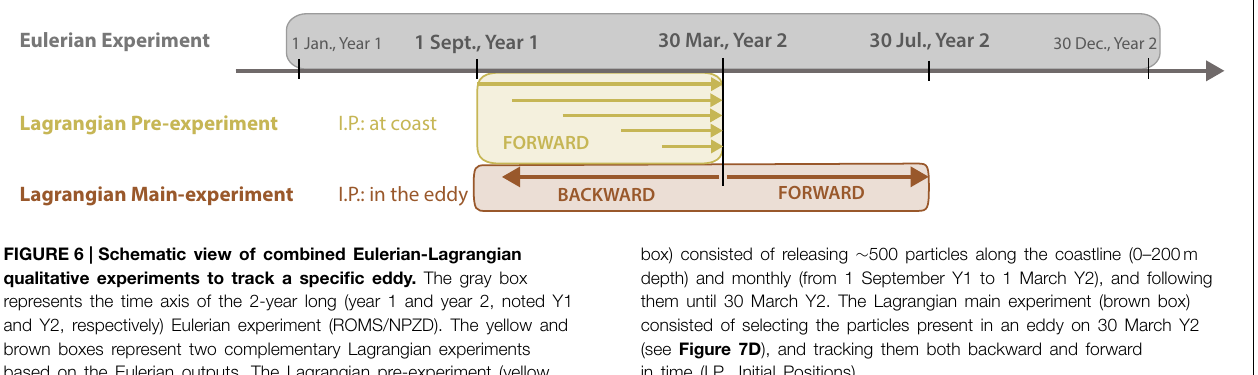
box) consisted of releasing ∼ 500 particles along the coastline (0–200m depth) and monthly (from 1 September Y1 to 1 March Y2), and following them until 30 March Y2. The Lagrangian main experiment (brown box) consisted of selecting the particles present in an eddy on 30 March Y2 (see Figure 7D ), and tracking them both backward and forward in time (I.P., Initial